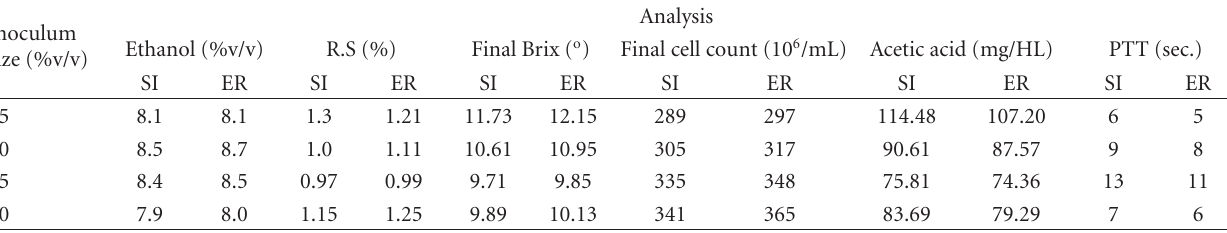
∗ SI: Saf-Instant and ER: Ethanol Red. Table 5: E ff ect of varying concentrations of lactrol on ethanol and acetic acid production by two commercial yeast strains ∗ using sugarcane molasses in fed-batch cultures. Lactrol con-